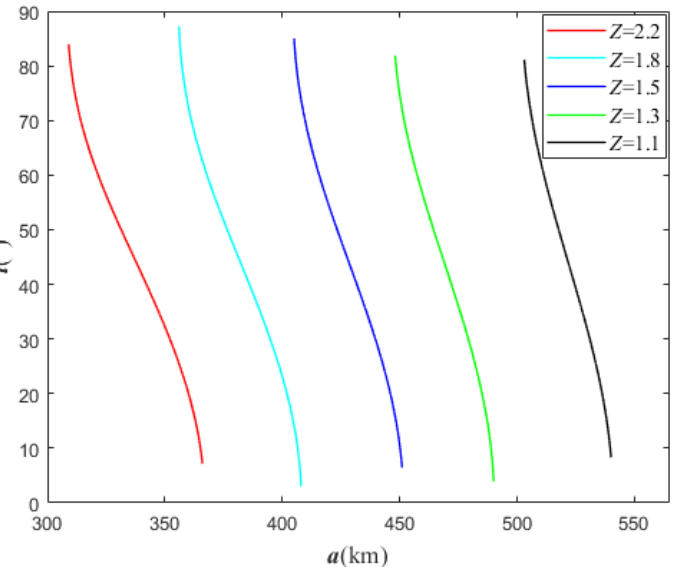
Figure 8. Inclinations i of Sun ‐ synchronous repeating ground circular track orbits as a function of the semi ‐ major axis a with different Z .